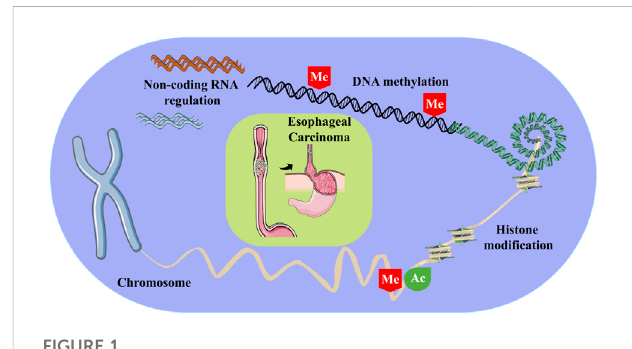
FIGURE 1 Some of the epigenetic modi fi cations involved in esophageal carcinoma, including DNA methylation, histone modi fi cations and non- coding RNA regulation. Of these, Me stands for methylation, and Ac stands for